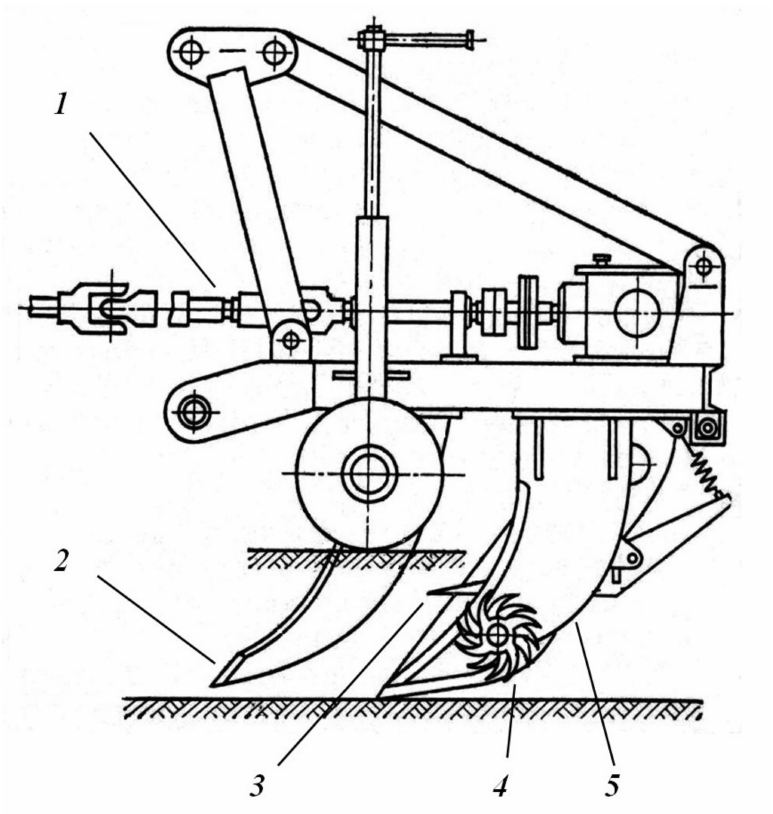
Figure 3. Mechanical scheme of intra-soil milling device. Mechanical drive 1, chisel for preliminary soil loosening 2, moldboard plow section 3, soil illuvial and transitional horizons milling ripper 4, passive ripper with closed gearing housing 5.